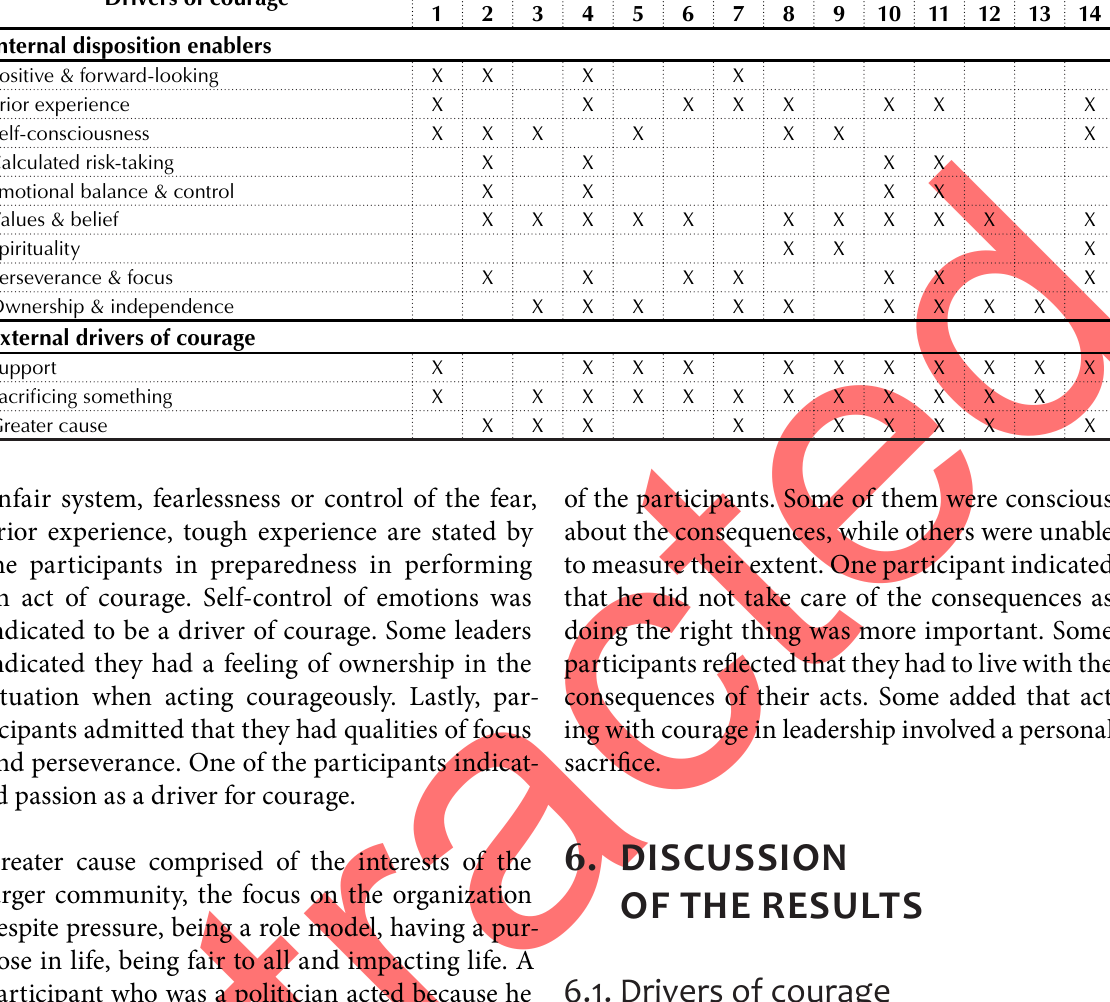
Table 2. The drivers of courage Drivers of